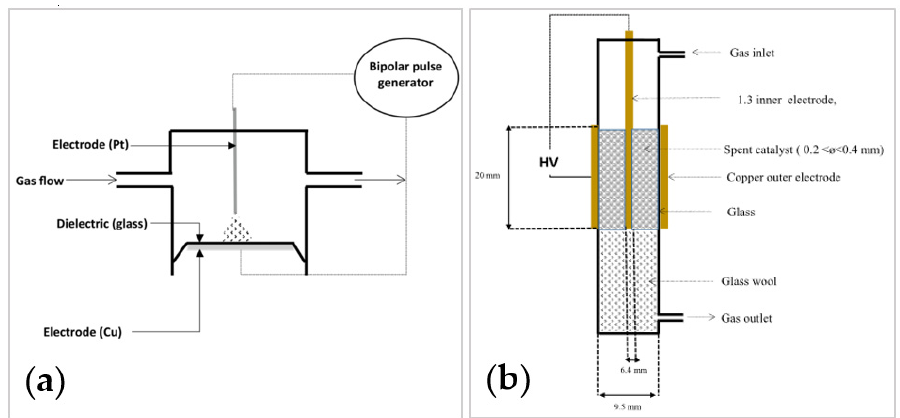
Figure 17. Schematic representation of ( a ) point-to-plate reactor [113] and ( b ) fixed-bed dielectric barrier discharge (DBD) reactor [153] for coked catalyst regeneration via NTP.